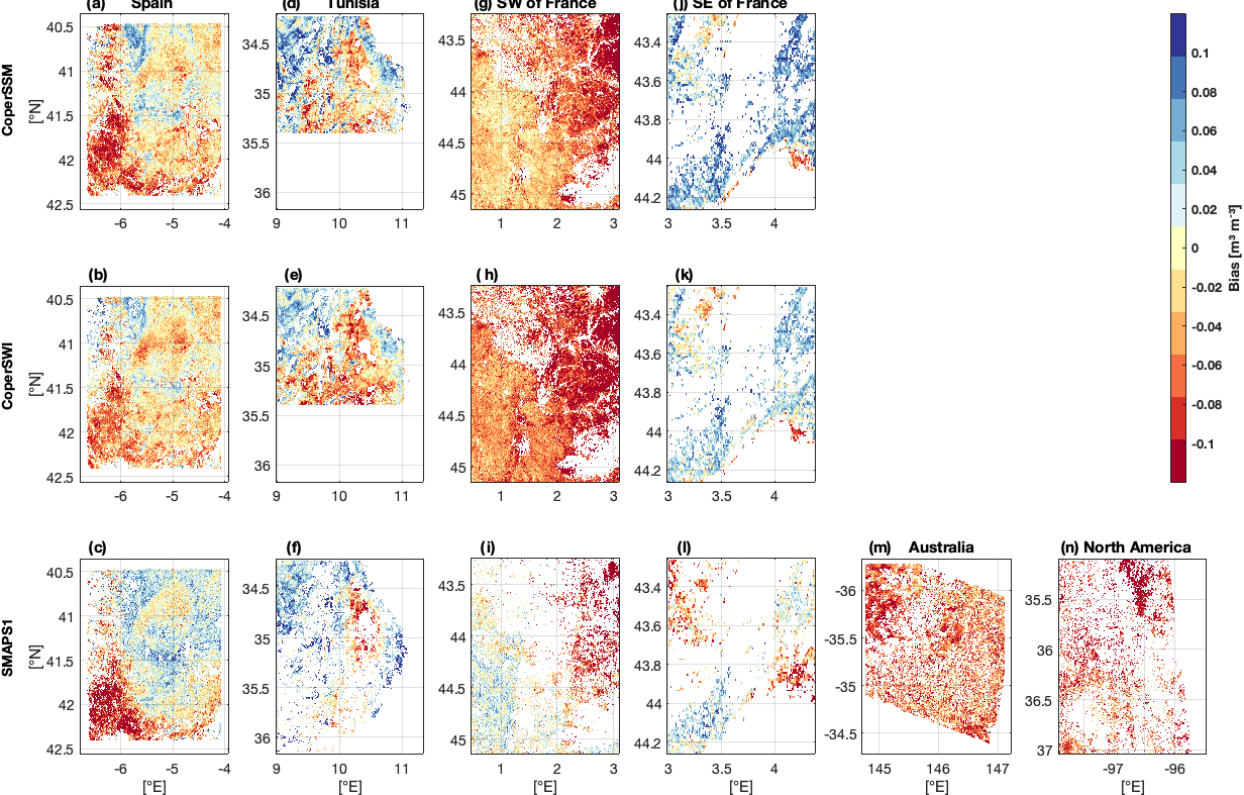
Figure 5. Comparison of S 2 MP S1S3 with respect to CoperSSM (S 2 MP S1S3 minus CoperSSM), CoperSWI (S 2 MP S1S3 minus CoperSWI), and SMAPS1 (S 2 MP S1S3 minus SMAPS1) over the regions of study in terms of bias (in m 3 m − 3 ). The analysis was performed from January to December